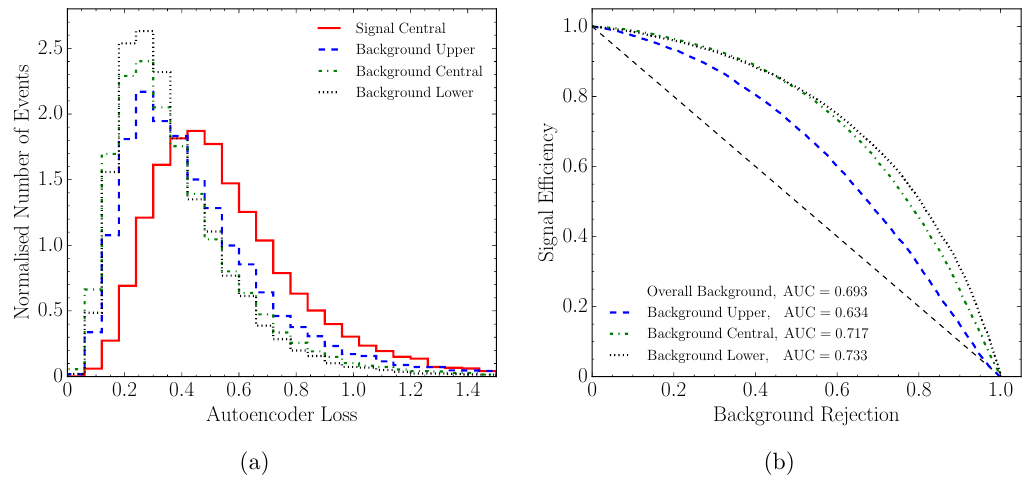
Figure 4. Autoencoder loss (a) and ROC curves (b) for an autoencoder trained only on background events. The three background distributions result from the three di(cid:11)erent directions of